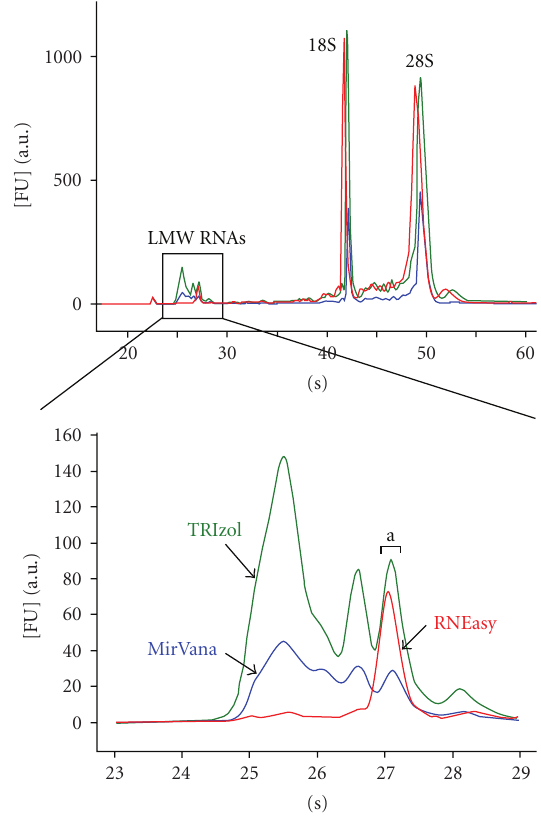
Figure 2: Agilent 2100 Bioanalyzer electropherogram profiles of total RNA samples (HeLa cells) extracted with TRIzol reagent (green), MirVana kit (blue), and RNEasy kit (red). Inbox: magni- fication of small RNA profiles for the three samples (between 23 and 29